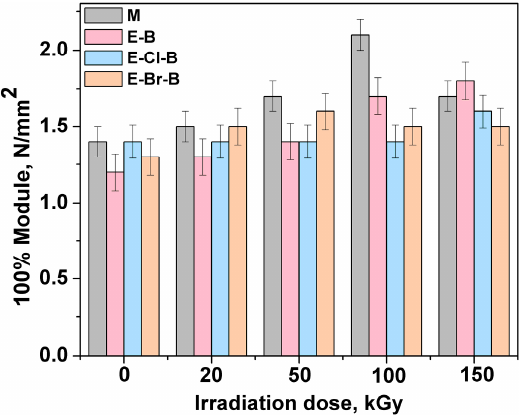
Figure 2. Elasticity of EPDM/butyl rubber composites as a function of irradiation dose. Polymers 2018 , 10 , x FOR PEER REVIEW